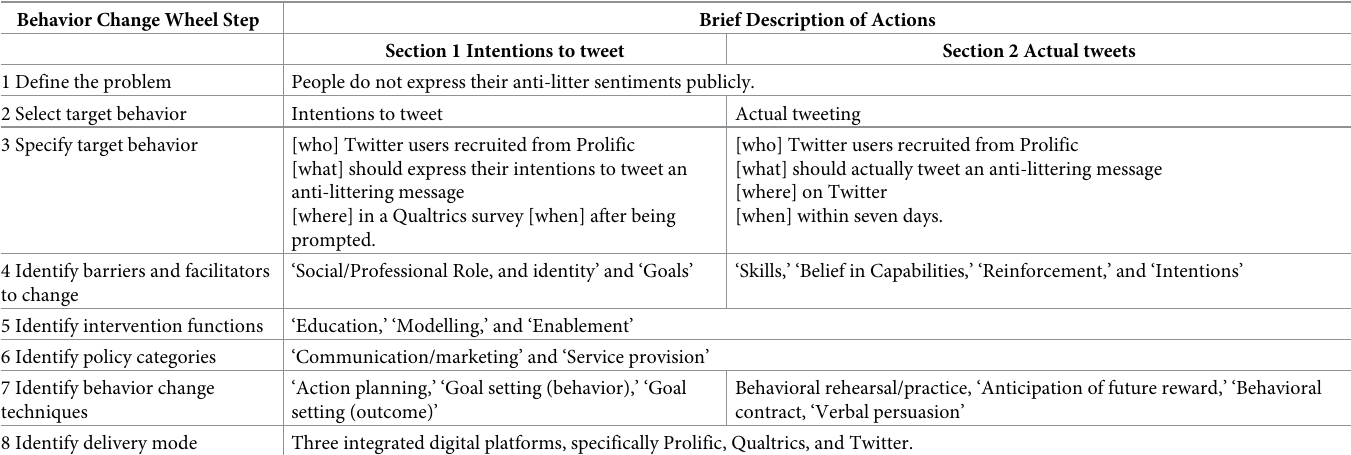
Table 3. Behavior Change Wheel steps and